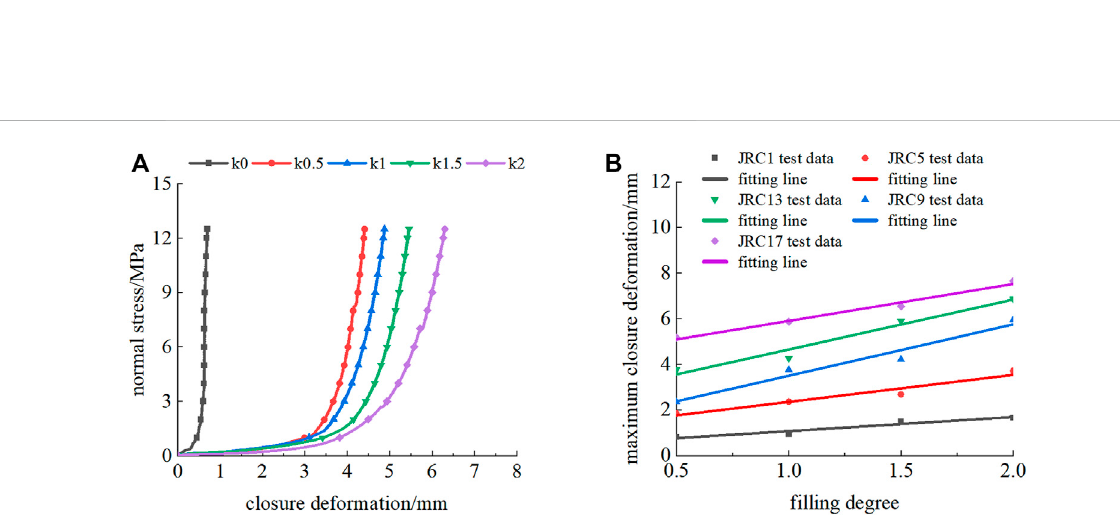
Frontiers in Earth